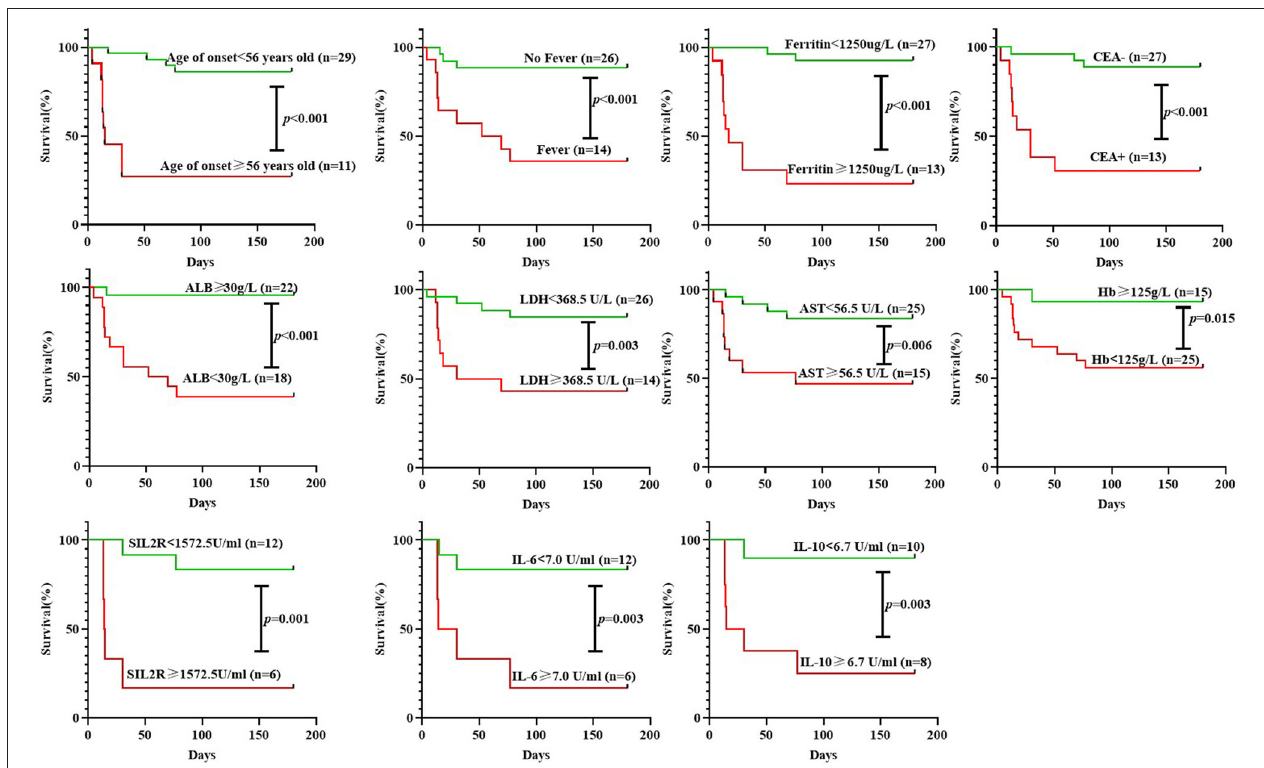
FIGURE 2 | Survival curve analysis of 6-month all-cause mortality in patients with anti-MDA5-positive DM according to different groupings. CEA, carcinoembryonic antigen; LDH, lactate dehydrogenase; AST, aspartate aminotransferase; Hb, hemoglobin; ALB, albumin; IL,